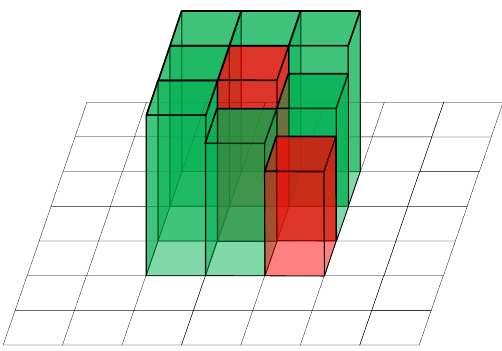
Figure 5. A square patch with a seed cell at the center and another seed cell at the corner. For each other cells without known elevation, the elevation is initialized as the average elevation of its neighboring seed